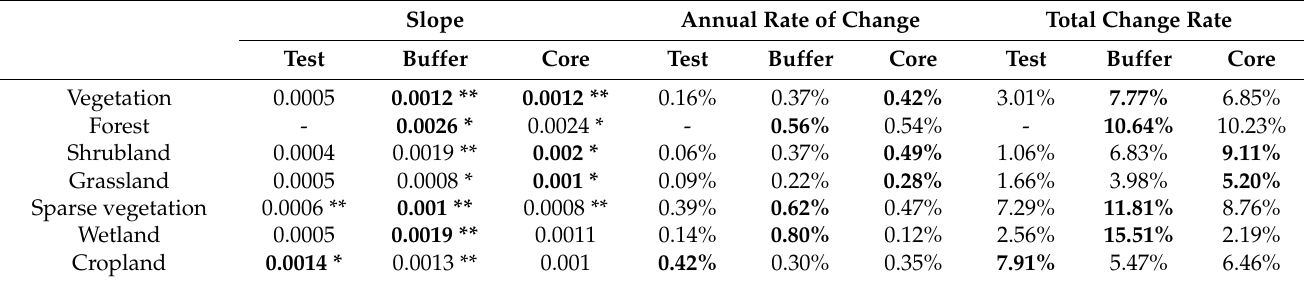
Figure 8. Detecting changes in climatic factors by considering the time effect in the QNNP during 2000–2018. Temperature ( a ) showed a shift from increase to decrease; both segments were insignificant. Precipitation ( b ) showed a monotonic decrease; both segments were insignificant. Radiation ( c ) showed the reverse trend, and both segments were significant. Table 2. Slopes and rates of change in the NDVI for different vegetation types in three zones of the